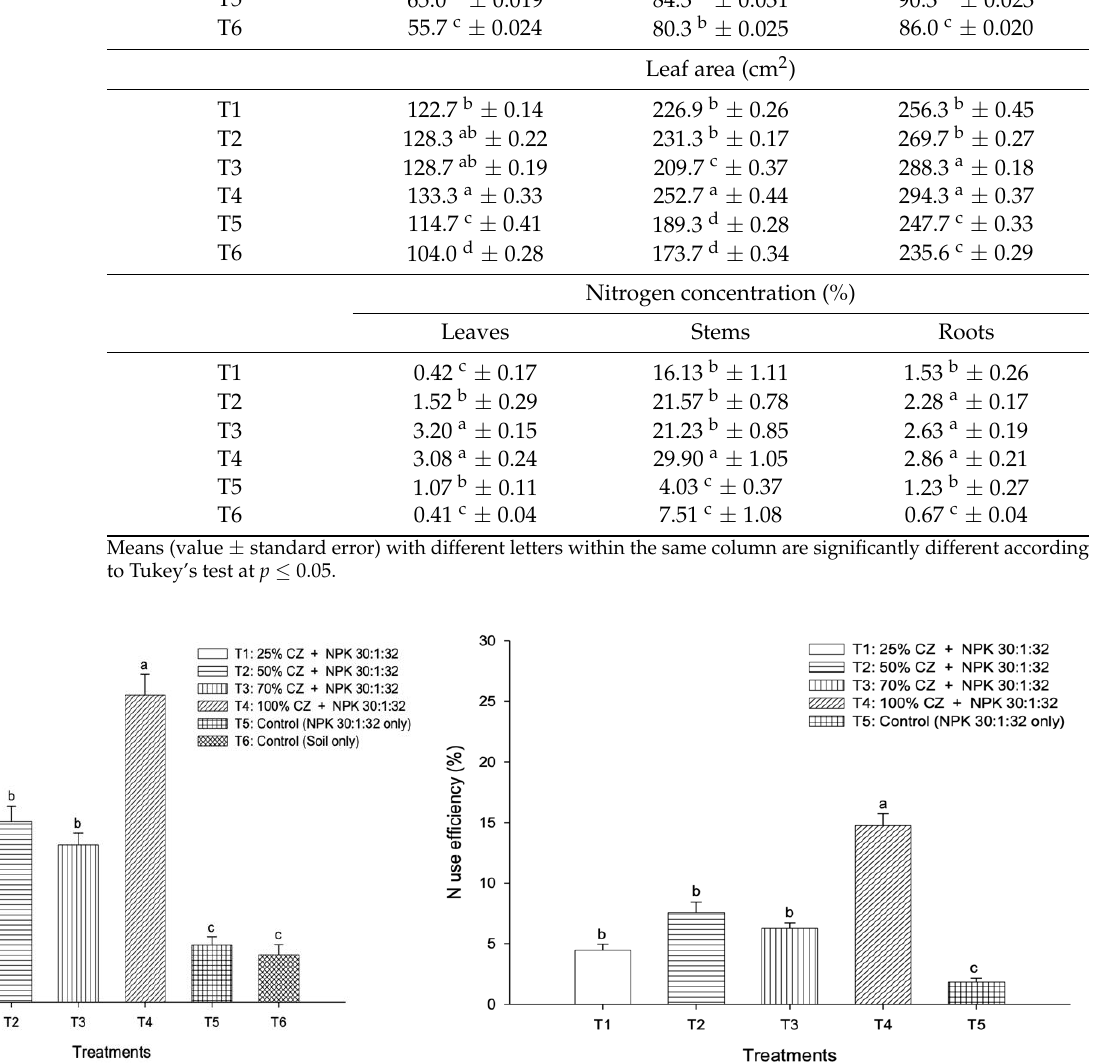
Figure 13. Effects of clinoptilolite zeolite and NPK fertilizer on ( a ) total nitrogen uptake (leaves, stems, and roots) and ( b ) use efficiency of Ananas comosus L. Merr var. Moris at harvest. Error bars indicate the standard error of the mean. Means with different letters are significantly different using Tukey’s test with p ≤ 0.05. CZ: clinoptilo lite zeolite.